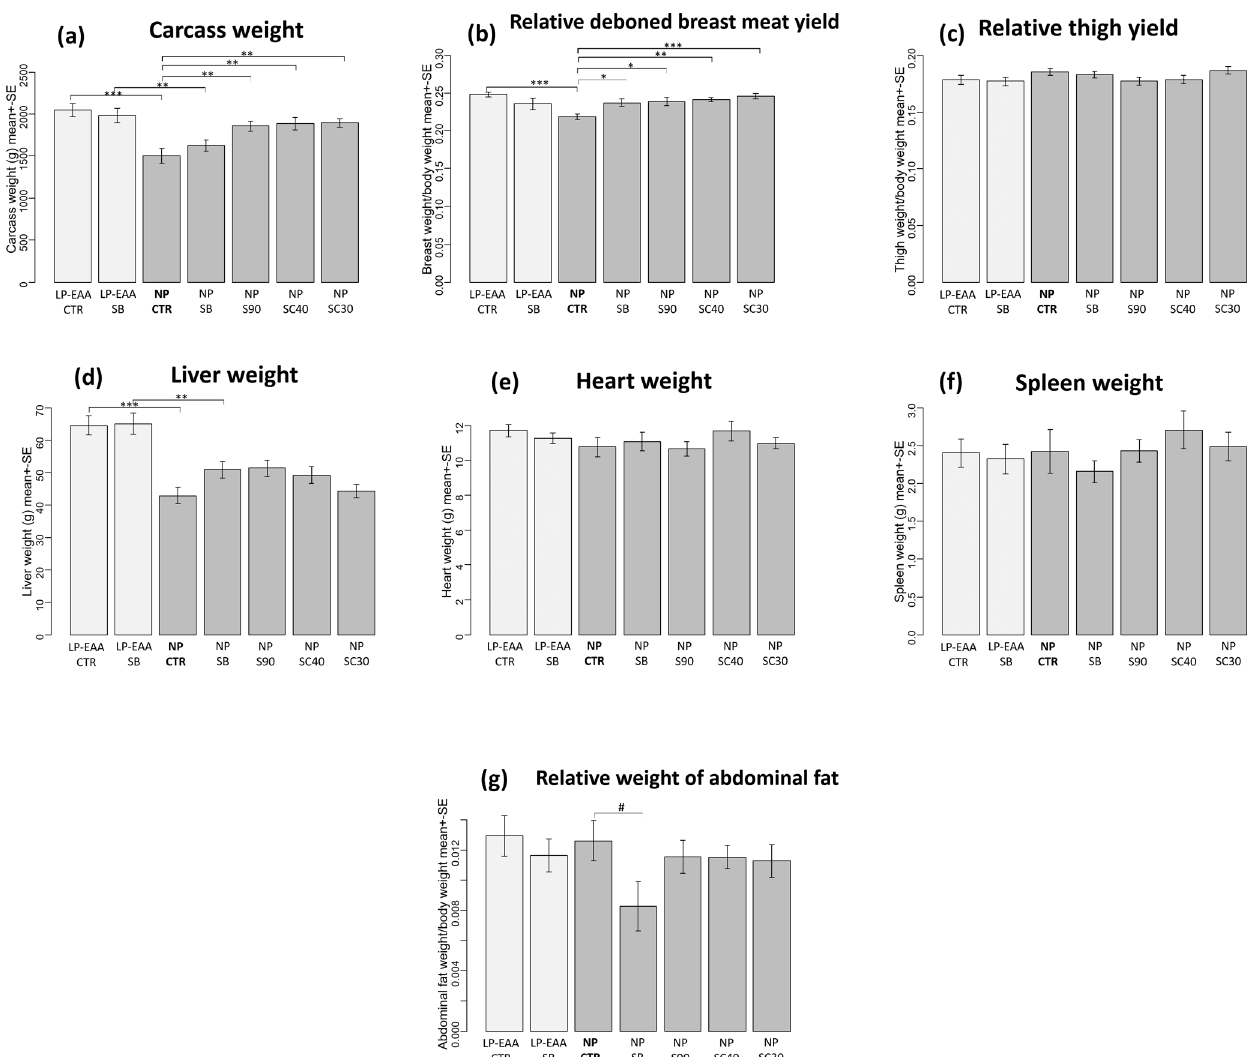
Figure 1. Results of carcass trait measurements. (a) Carcass weight. (b) Relative deboned breast meat yield. (c) Relative thigh yield. (d) Liver weight. (e) Heart weight. (f) Spleen weight. (g) Relative weight of abdominal fat. The abbreviations of the experimental groups are indicated in Table 1. Results are expressed as mean ± SE. Significant differences revealed by post hoc tests are marked with the following symbols: # P < 0 . 10; ∗ P < 0 . 05; ∗∗ P < 0 . 01; ∗∗∗ P < 0 .